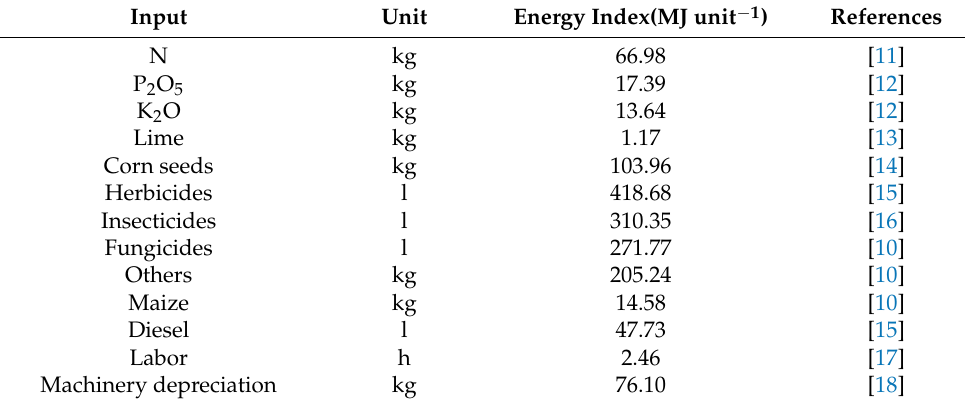
Table 1. Energy index for directly applied